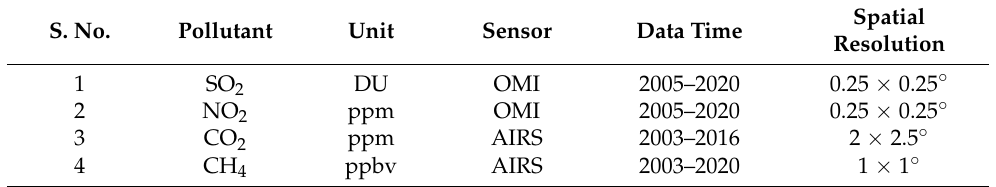
Spatial Resolution